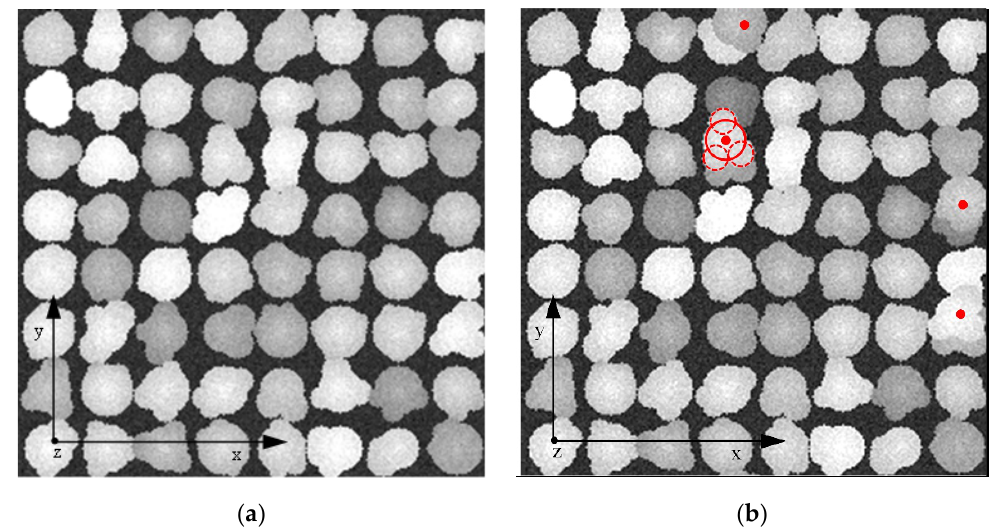
Figure 8. Two consecutive simulated images, ( a ) first simulated image, ( b ) second simulated image. The red points represent the active particles. The solid red circle and dotted red circles mean the combination of one particle.